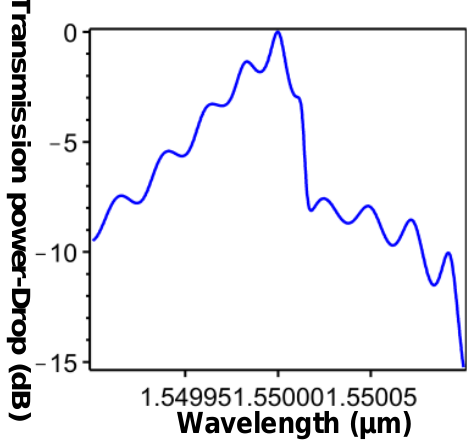
Figure 17. Spectrum of the FBG-OADM when the core mode was completely dropped.